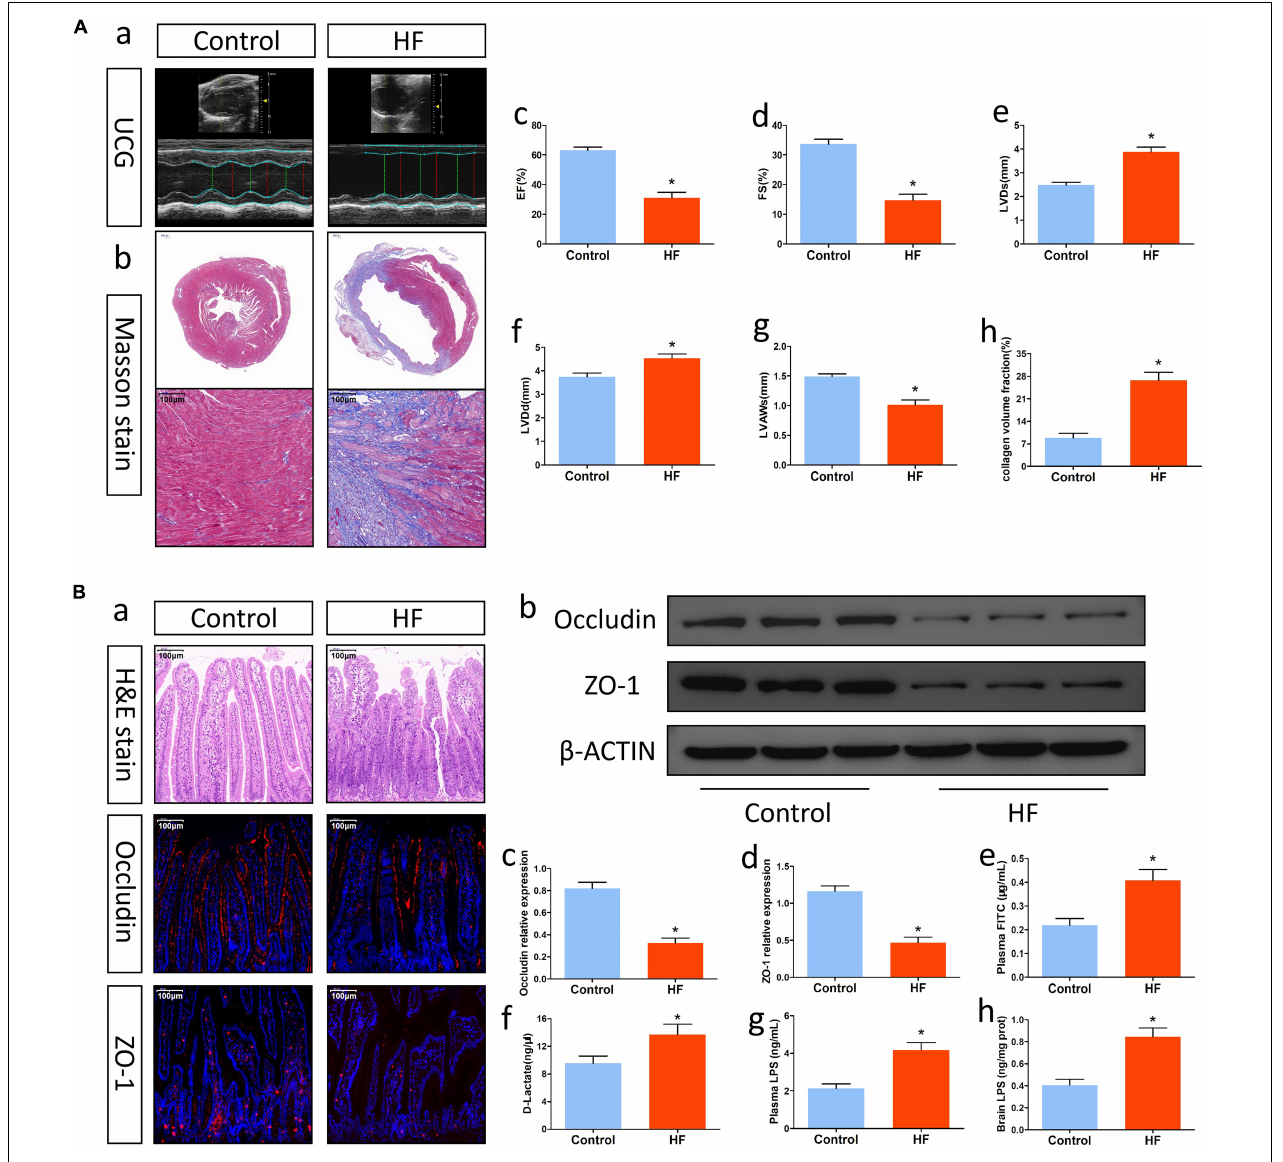
FIGURE 1 | Alterations in cardiac function and intestinal barrier function after HF. (A) Changes in cardiac function. (a) Representative echocardiography tracings. (b) Representative images of Masson’s trichrome-stained cardiac tissue (magnification, 10 × and 200 × ). (c) EF. (d) FS. (e) LVDs. (f) LVDd. (g) LVAWs. (h) Collagen volume fraction analysis of the results in (b) . (B) Alterations in intestinal barrier function after HF. (a) Representative images of H&E staining and representative immunofluorescent images of anti-occludin and anti-ZO-1 staining in the intestine (magnification, 200 × ). (b) Western blot analysis of the relative levels of Occludin, ZO-1 and expression of the control β -actin in intestinal tissue. (c,d) Quantitative analysis of Occludin and ZO-1 expression. (e) Plasma FITC-dextran concentrations in each group. (f) The levels of plasma D-Lactate in mice. (g) The levels of plasma LPS in mice. (h) The levels of brain LPS in mice. * P < 0.05 vs. the control group. EF, ejection fraction; FS, fractional shortening; LVDs, left ventricular end systolic diameter; LVDd, left ventricular end diastolic diameter; LVAWs, left ventricular anterior wall systolic thickness; LPS,